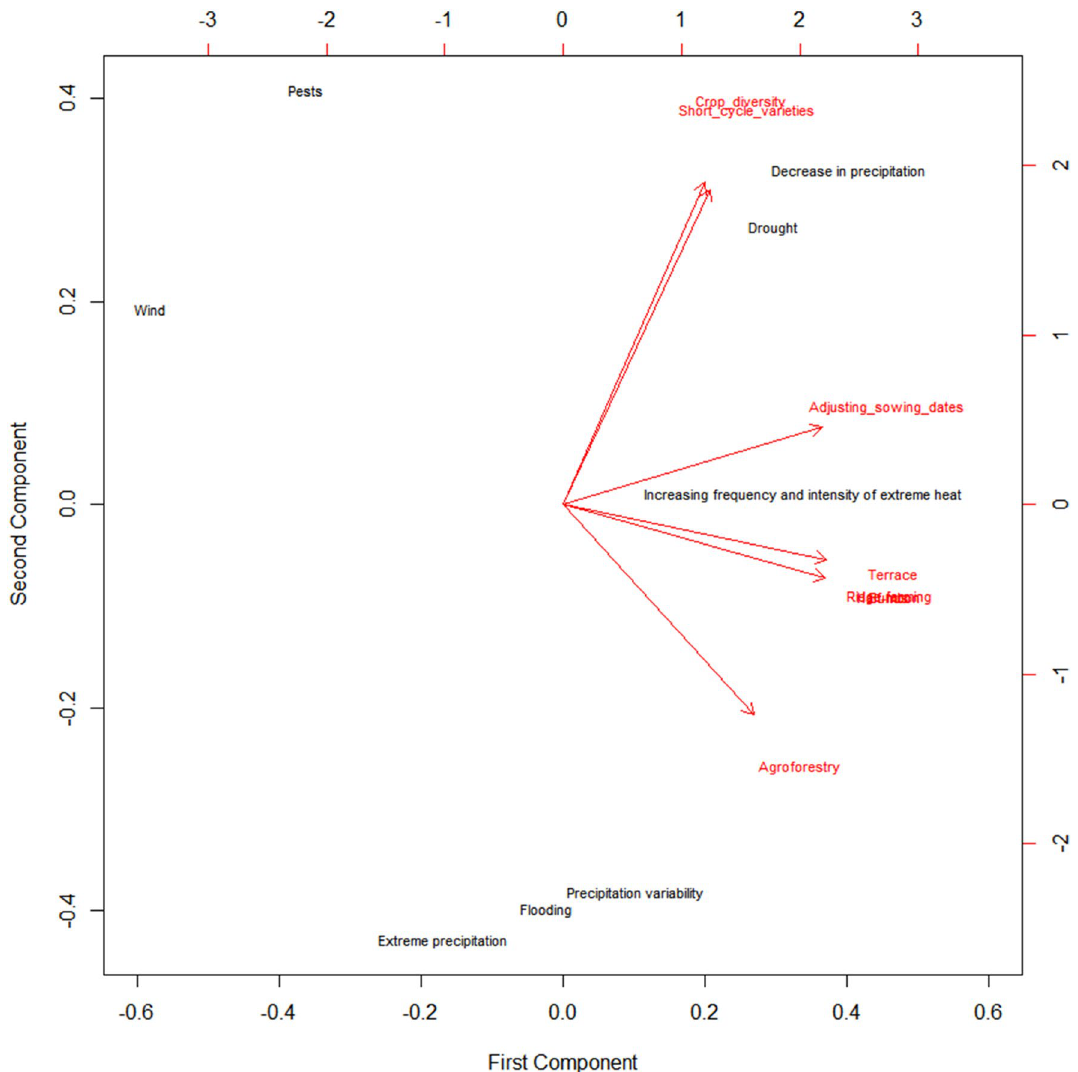
Fig. 6 Principal Component Analysis (PCA) for perceived vulnerability to hazards and adaptation